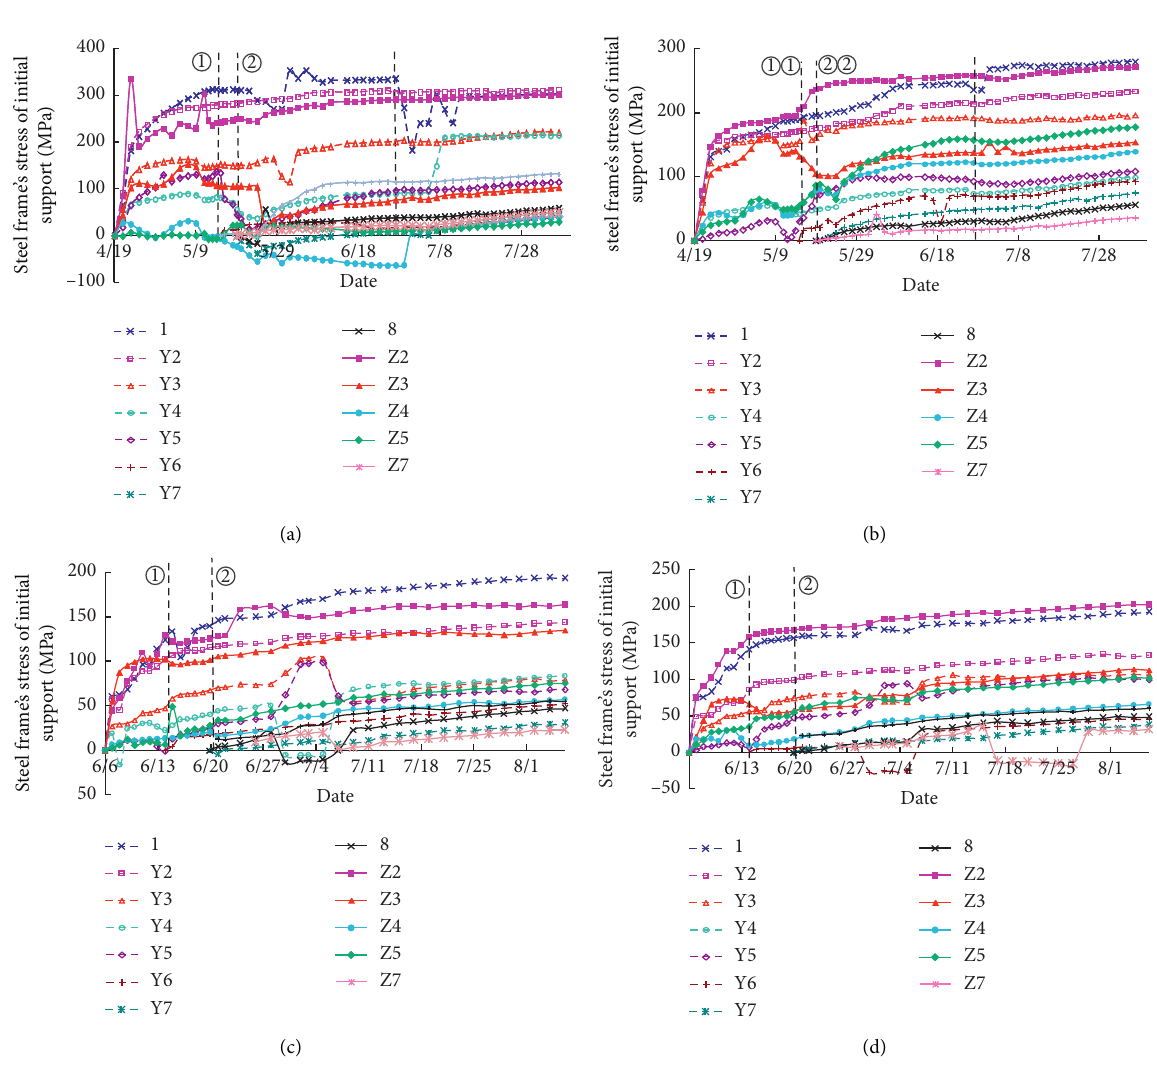
Figure 13: Variation curves of steel frame’s stress of initial support. (a) Outer flange of section A. (b) Inner flange of section A. (c) Outer flange of section C. (d) Inner flange of section